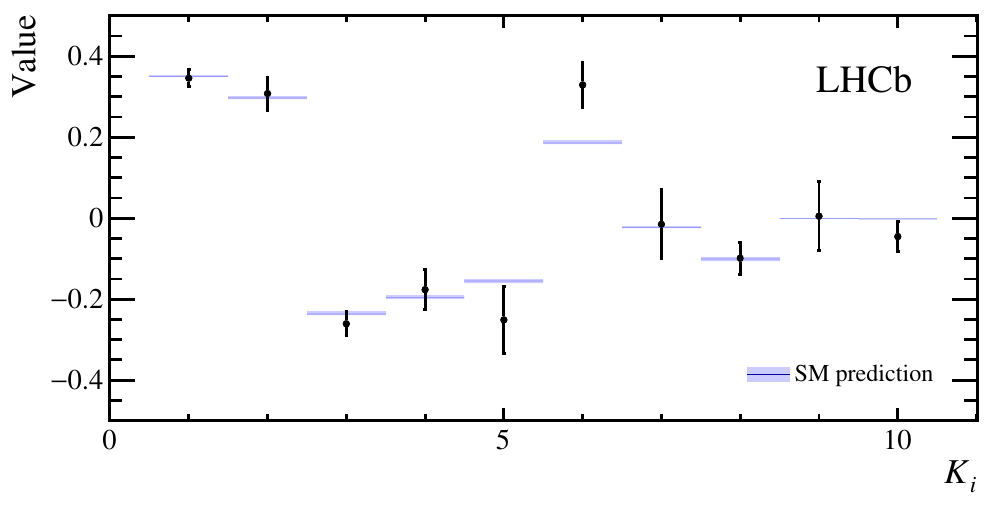
Figure 3 . Angular observables combining the results for the moments obtained from Run 1 and Run 2 data, as well as candidates reconstructed in the long- and downstream-track p(cid:25) (cid:0) categories. The blue line represents the SM predictions obtained using the EOS software. The thickness of the light-blue band represents the uncertainty on the SM